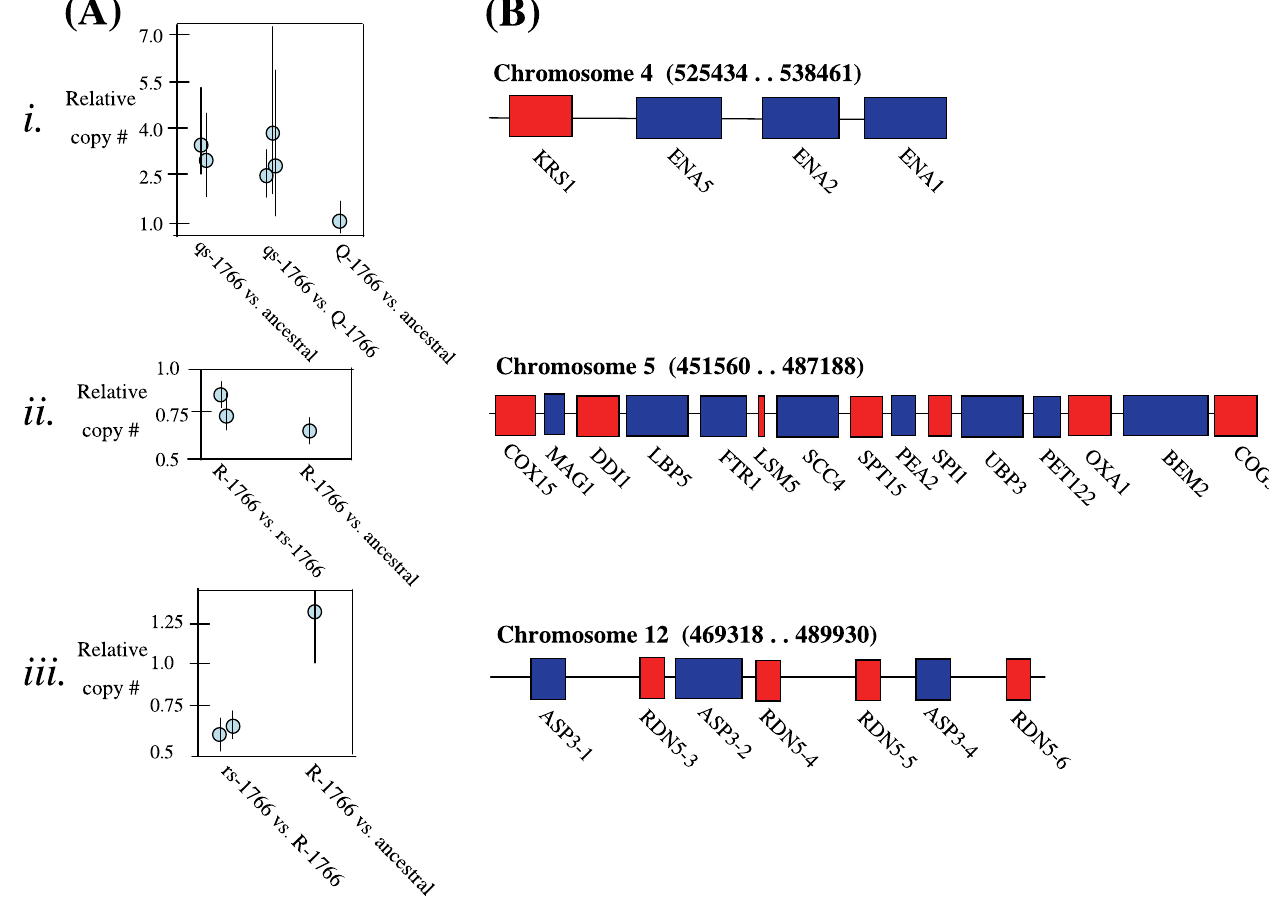
Figure 2. The Three Indels Identified by CGH Analysis of Ancestral (Generation 0) and Evolved (Generation 1,766) Tetraploid Lines (i) An insertion of a ; 13-kilobase fragment on Chromosome 4 in tetraploid salt line qs; (ii) a potential ; 36-kilobase deletion of Chromosome 5 in tetraploid line R; (iii) a potential 20-kilobase deletion of Chromosome 12 in tetraploid salt line rs. (A) Results of CGH, where each dot represents the mean (bars: 95% CI) relative copy number of all genes in the indel from a single array. (B) Genes of known function (http://www.yeastgenome.org, 2 October 2005) affected by the indel (basepair range of genes involved are given in brackets). Each box is one ORF, where red indicates transcription on the Watson strand, and blue for genes transcribed on the Crick strand. DOI: 10.1371/journal.pgen.0020145.g002